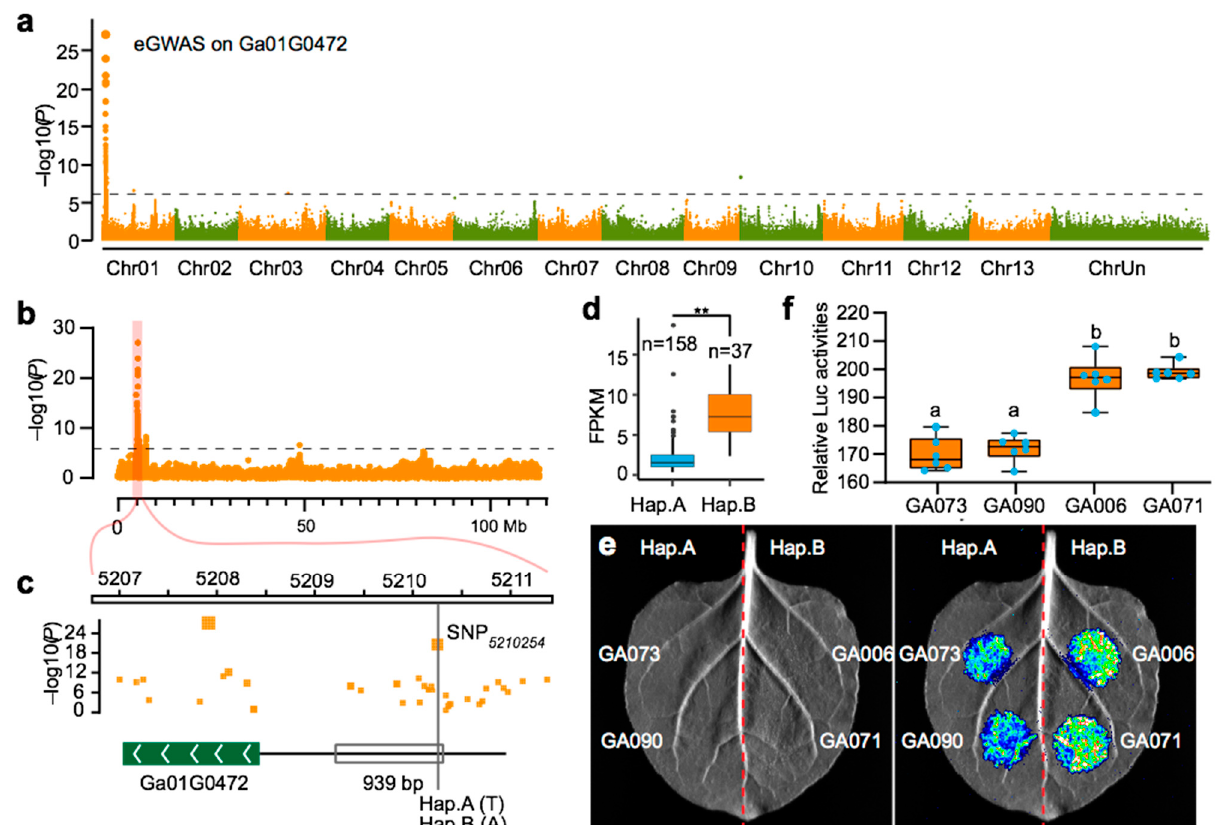
Figure 2. Cis-eQTL regulated gene expression. ( a ) Genome-wide association study (GWAS) on Ga01G0472 expression. ( b ) Manhattan plot of the eGWAS signal of Ga01G0472 on chromosome 01. ( c ) The position of the 939-bp fragment used in the Ga01G0472 promotor used in the Luc assay showing associated SNPs. The lead SNP, Chr 01:5210254, is indicated by a vertical line. ( d ) The divergence of Ga01G0472 expression between different alleles of the cis-eQTL. Student‘s test, ** p < 1 × 10 3 . ( e ) Luminescence of Nicotiana benthamiana leaves infiltrated with vectors for containing different alleles of the Ga01G0472 a promoter driving LUC ( Ga01G0472 pro:Luc). Fragments from accessions GA073, GAO90, GA006, GA071 for both Hap. A and Hap. B were used. ( f ) Quantification of the luminescence signals shown in ( e